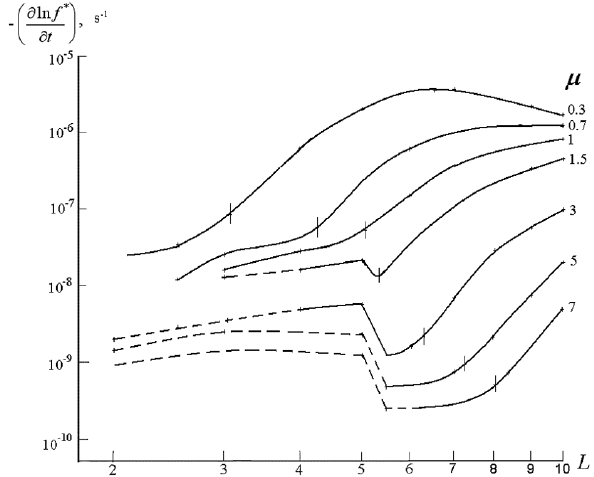
Figure 3. The radial dependence of the rates of the ionization losses of protons with various µ calculated with regard to the shape of the energy spectra of protons based on the ISEE-1 data from Williams and Frank (1984) for a period of 17 November 1977. Here µ is given in kiloelectronvolt per nanotesla. The jump on these curves at L = 5.0–5.5 corresponds to a sharp drop in electron density near the plasmapause. The vertical cuts on these curves mark L , at which rate the Coulomb loss is equal to the charge exchange rate of the protons.